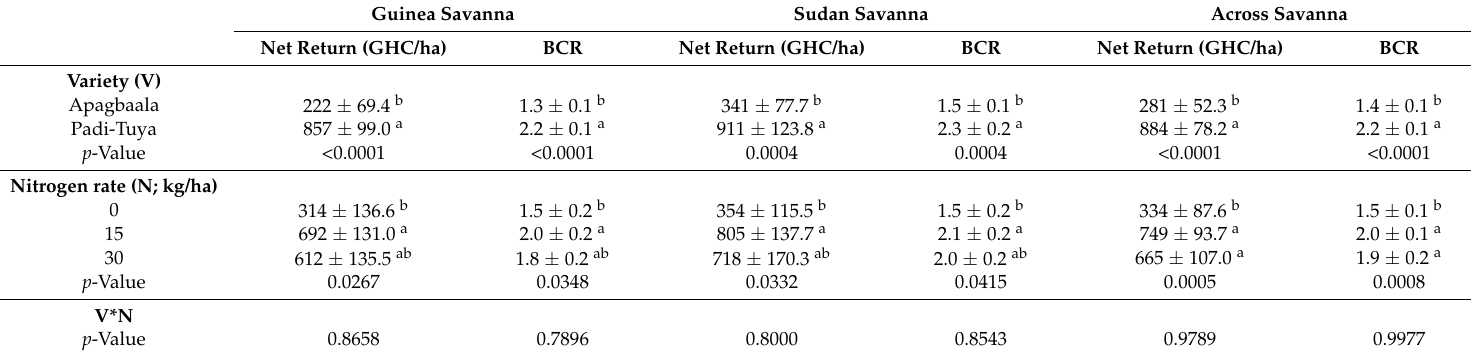
Table 2. Net return and benefit-cost ratio (BCR) from cowpea grain yield only as affected by variety and N fertilizer rate averaged across 2013 and 2014 cropping